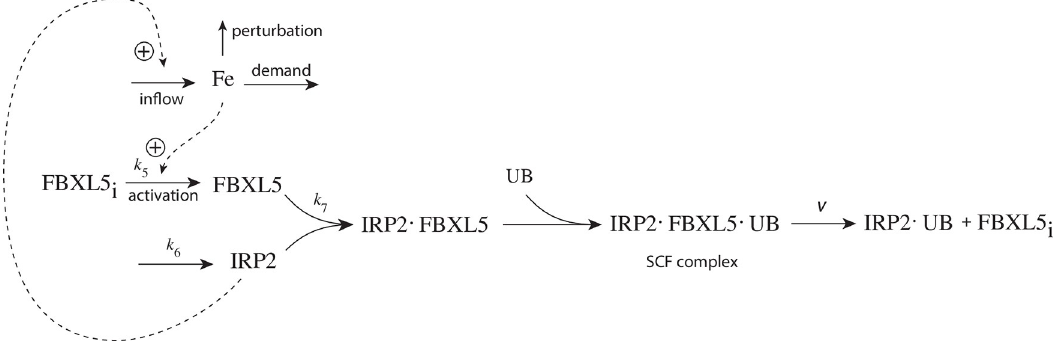
Fig 66. Suggested mechanism for the inflow control regulation of iron in mammalian cells. IRP2 activtes and stabilizes reactions promoting the inflow of iron into the cell. Iron activates the enzyme FBXL5 (FBXL5 i is an inactive form) which enables the binding of IRP2 and UB leading to ubiquitinated IRP2. In this way IRP2 is moved out of the negative feedback loop.